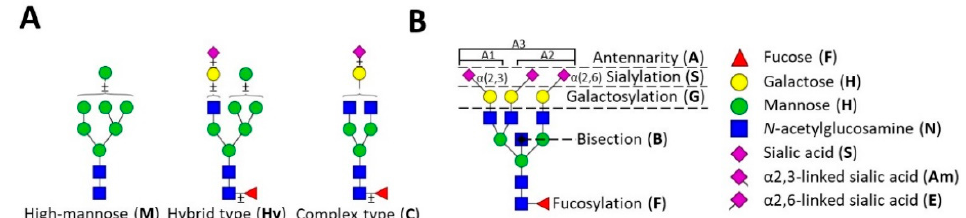
Figure 1. N -glycan structural features. The three major classes of human N -glycans are schematically presented ( A ) and the major structural features of complex-type N -glycans are introduced ( B ). Adaptation from [19] .